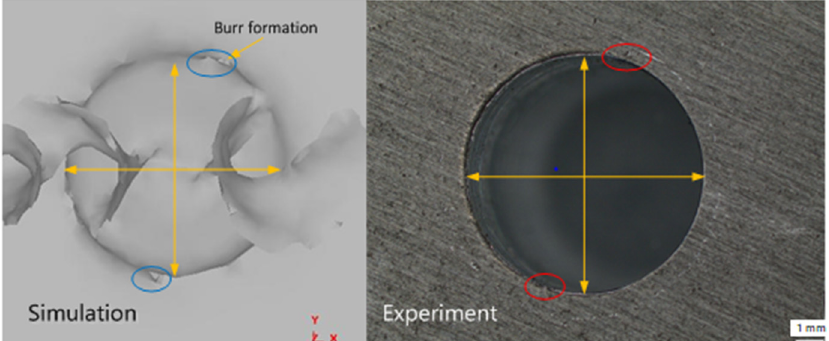
Figure 16. Drilling formation and burr generation (spindle speed is 800 rpm and feed speed is 140 mm/min).